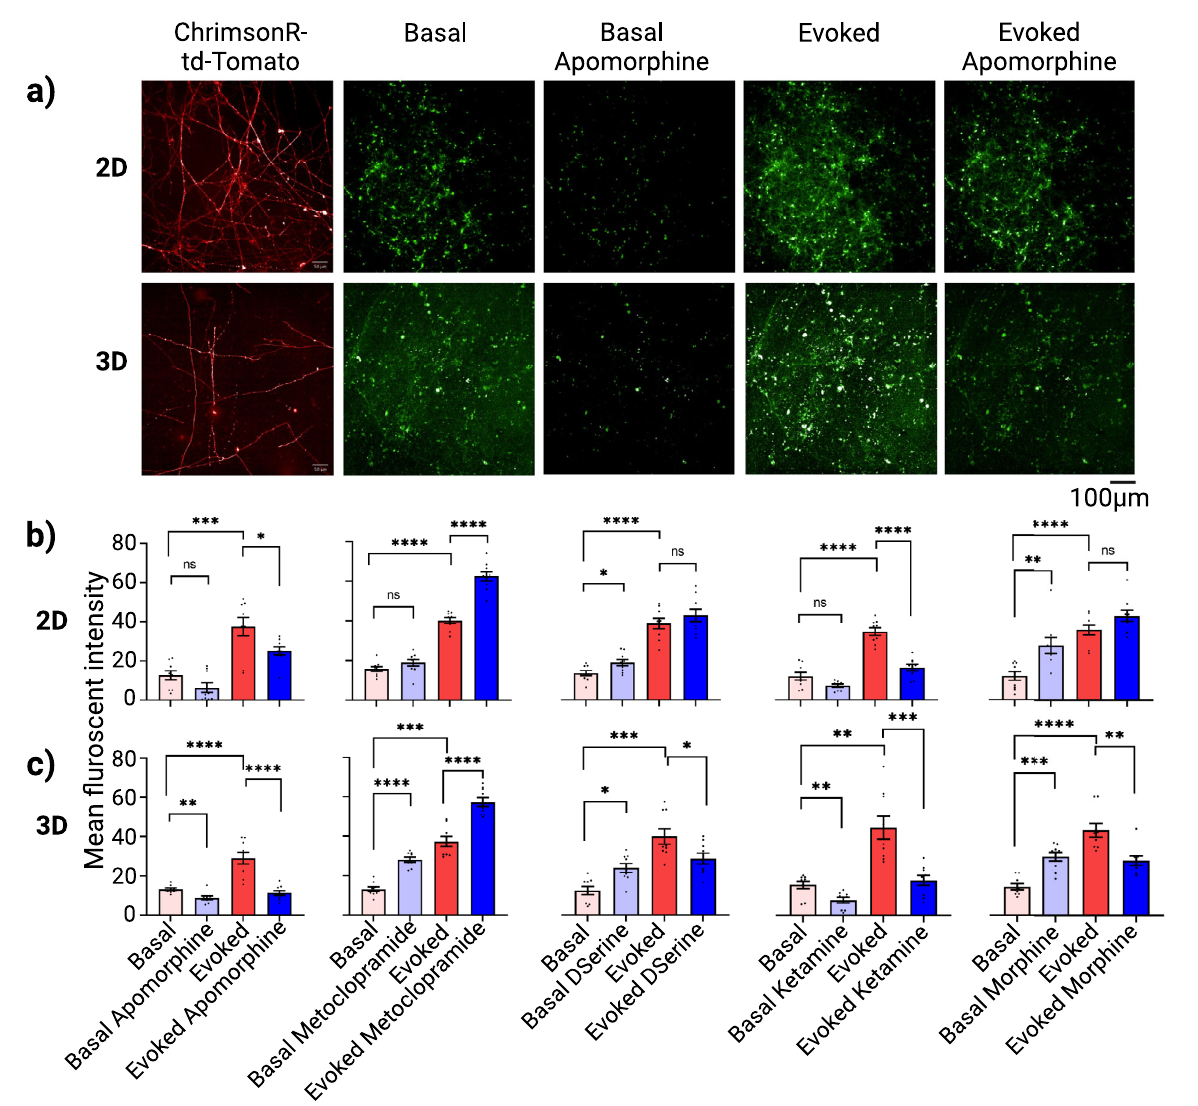
Fig. 7 Image-based quantitation and pharmacological modulation of dopamine release by genetically encoded dopamine sensor in iDopas/iAstros 2D and 3D co-cultural model. The genetically encoded dopamine biosensor, hSyn-dLight1.2, was used to quantitate release of dopamine neurotransmitter at the synaptic clefts in the 2D and 3D gel neural co-culture models. a Representative images of expression of ChrimsonR via td-Tomato fl uorescence, dopamine neurotransmitter release via dLight1.2 as green puncta at the synapses, for both basal and optical stimulation, and with or without Apomorphine, the D2-receptor agonist treatment. b , c Quantitative estimation of mean fl uorescent intensity from multiple fi elds of views for 2D system ( n = 9 wells) and from entire z-stack along with multiple fi elds of views for 3D system ( n = 9 wells) were accumulated and presented as bar plots. Quantitation of dopamine release by measuring green fl uorescence from dLight1.2 biosensor in 2D ( b ) and 3D ( c ) models, after 30 min min treatment with apomorphine, metoclopramide, D-serine and ketamine at 10 µ M, and morphine at 15 µ M. Scale bar 50 µ m. Error bar s.e.m. three technical replicates, with n = 3 wells each. Statistics: Two-way ANOVA with post hoc turkey test between density of 2000K/mm 3 in neuronal spheroids 54 . We were able to mix 25 K/µl of human iPSC derived either dopaminergic or glutamatergic neurons, combined with human iPSC derived astrocyte in 1:5 ratio. The confocal microscopic images revealed that the height of our 3D gel-based structures was 100 – 300 µm in 384 multiwell plate format, thus estimating a neuronal density of around 95K-100K/mm 3 in our 3D fi brin gel-based tissue mimic, which is only 2 – 3-fold higher than the average neuronal density of human brain, still demonstrating physiologically relevant ‘ in- network ’ functional modulation. 3D rendered images of the antibody staining of our 3D gel-based model provided the evi- dence of long axonal projections, spreading both horizontally and vertically, with the expression of neuronal selective markers like